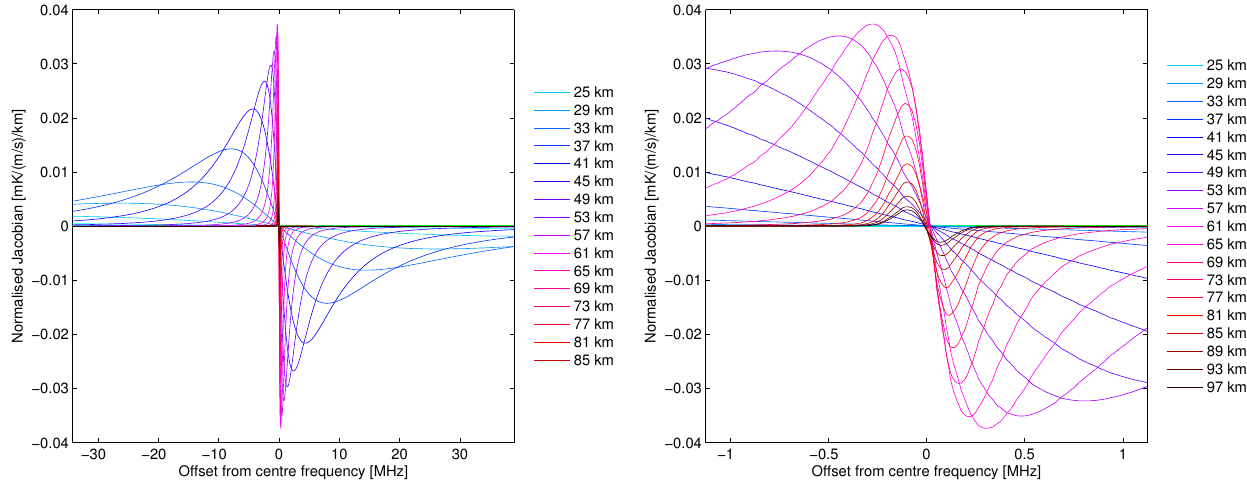
Figure 5. Rows of the Jacobian describing WIRA’s horizontal wind retrieval normalised by the layer thickness of the retrieval grid for observations at 22 ◦ elevation. Full usable spectrometer bandwidth (left) and zoom on the central channels